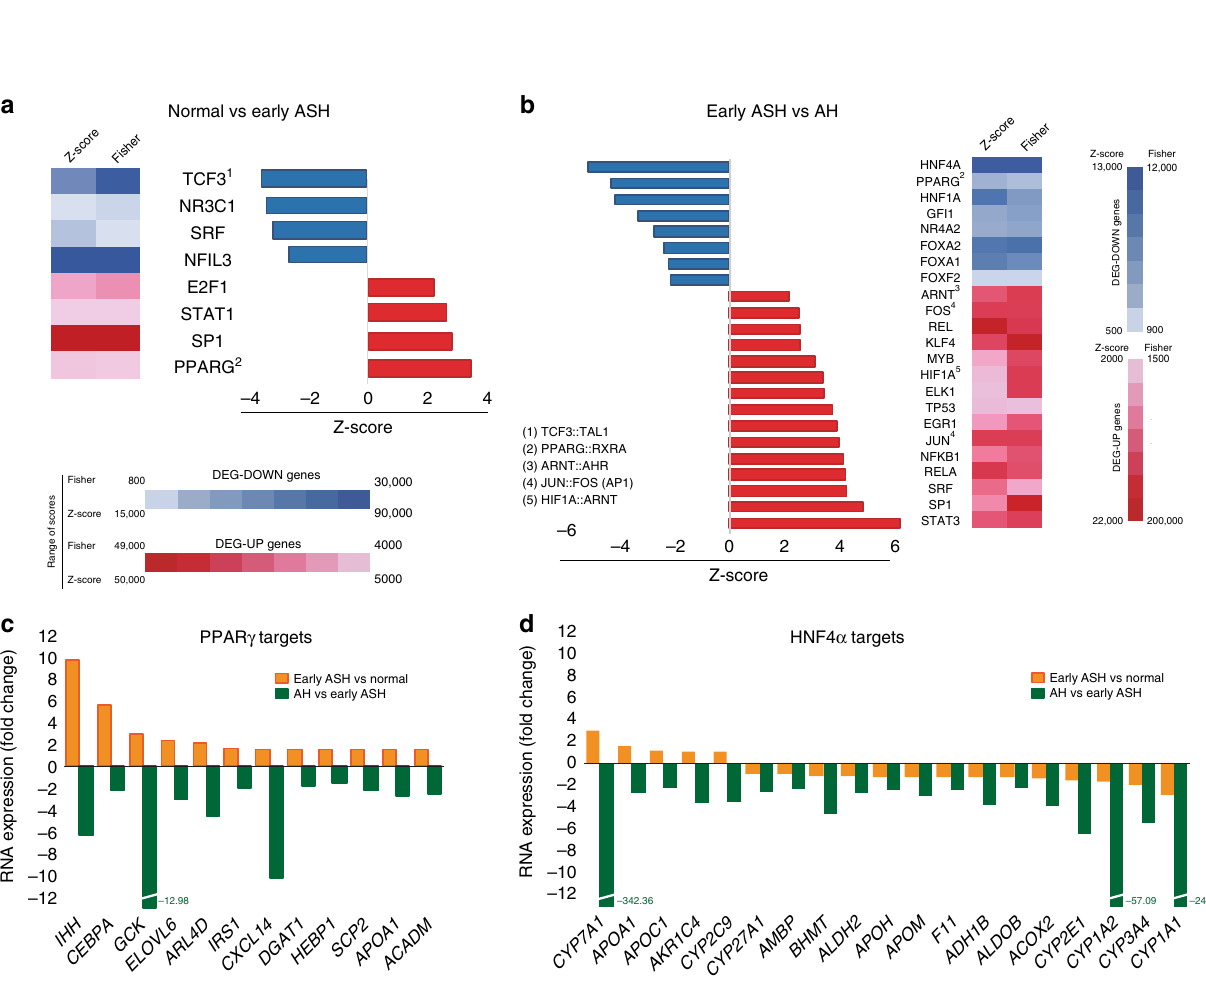
Fig. 1 Liver transcriptome encompasses disease progression in patients with ALD. a Human phenotypes included in the RNA-seq analysis: normal human livers ( n = 10), early ASH ( n = 12), AH ( n = 18) and explants from AH patients ( n = 11). Diseased controls: liver biopsies from patients with NAFLD ( n = 9), non-cirrhotic HCV ( n = 9) and compensated cirrhosis ( n = 9). Unbiased clustering and Short Time Expression Miner (STEM) algorithm were used to group patients by RNA pro fi ling and to identify main time-correlated patterns of expression. Kendall rank correlation coef fi cient and differential expression analysis ( limma ) between “ Normal ” and “ Early ASH ” and between “ Early ASH ” and “ AH ” groups was performed. Motif enrichment analysis (Opossum) and network analysis (Ingenuity Pathway Analysis) were used to identify main transcription factors involved in gene expression changes. b A schematic summary of Principal component analysis (PCA). c Heatmap of clinical and laboratory data of ALD patients: (Top) liver function tests: albumin serum levels, International Normalized Ratio (INR), aspartate aminotransferase (AST) and total serum bilirubin levels; (Bottom) Liver prognostic scores including Child-Pugh, MELD and ABIC; The color scale on the right indicates the range of each laboratory or clinical parameter. d Heatmap of STEM results, showing average expression (normalized log counts) of main groups of genes based on gene enrichment pro fi le expression. Left column: STEM pro fi le and number of genes. On top, patient phenotypes. Right panel, hierarchical clustering of pro fi les. See Supplementary Fig 2 for additional data from STEM analysis. e Heatmap of STEM results showing mean counts for all pattern-grouped genes for patients belonging to each disease stage. In the right panel, schematic representation (thick arrows) of main time-related expression patterns. f IPA analysis showing upstream regulators and soluble factors for each of four general expression pattern clusters. Regulators identi fi ed as cytokines, growth factors and receptors with a threshold ZS of 2 are presented (top-middle). Among the most 100 differentially expressed genes for each analysis, genes encoding secreted proteins are presented (bottom)